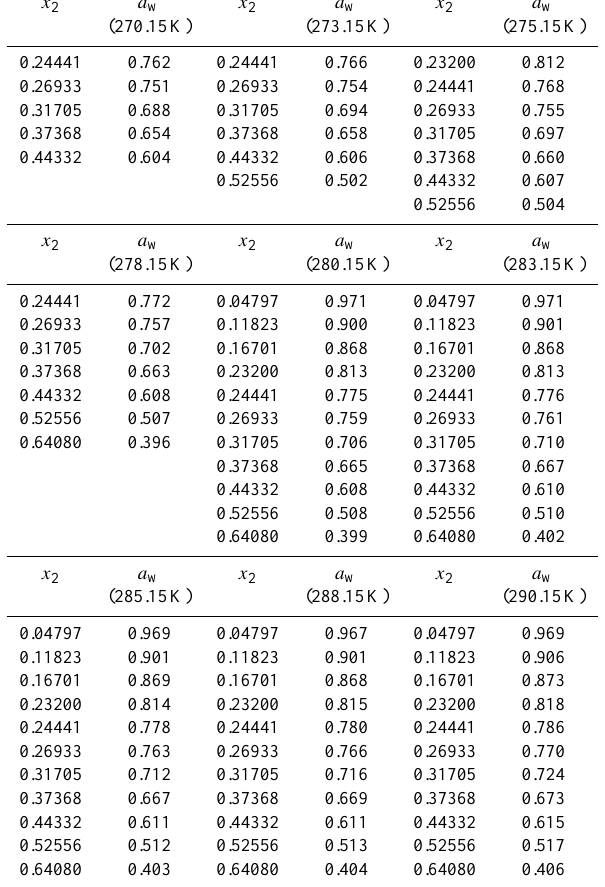
Table 12. Measured water activities of water (1) + 1,4- butanediol (2) mixtures derived from total gas phase pressure mea- surements ∗ , listed for a selection of temperatures in the range 270K <T < 291K. Solution compositions are given in mole frac- tions of the organic (x 2 )